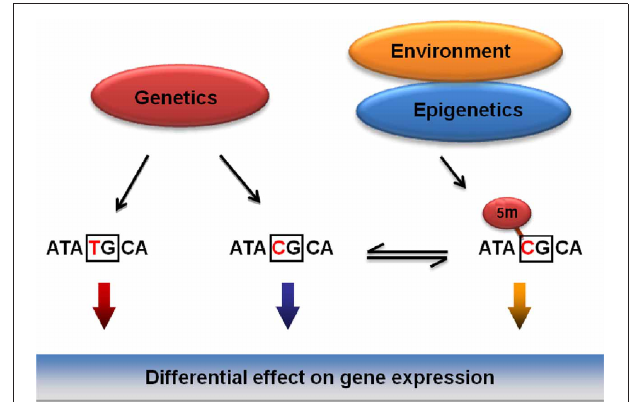
FIGURE 3 | General model for the integration of genetic, epigenetic and environmental factors on vulnerability to develop addictive disorders. Mechanistically, the effects of these factors may be integrated through methylation of CpGs overlapping with SNPs (mSNPs) associated with a disease. In the CpG context, the C, one of the two genetic alleles may be methylated and function as two epialleles, the C and 5 Me-C, that may differentially affect gene